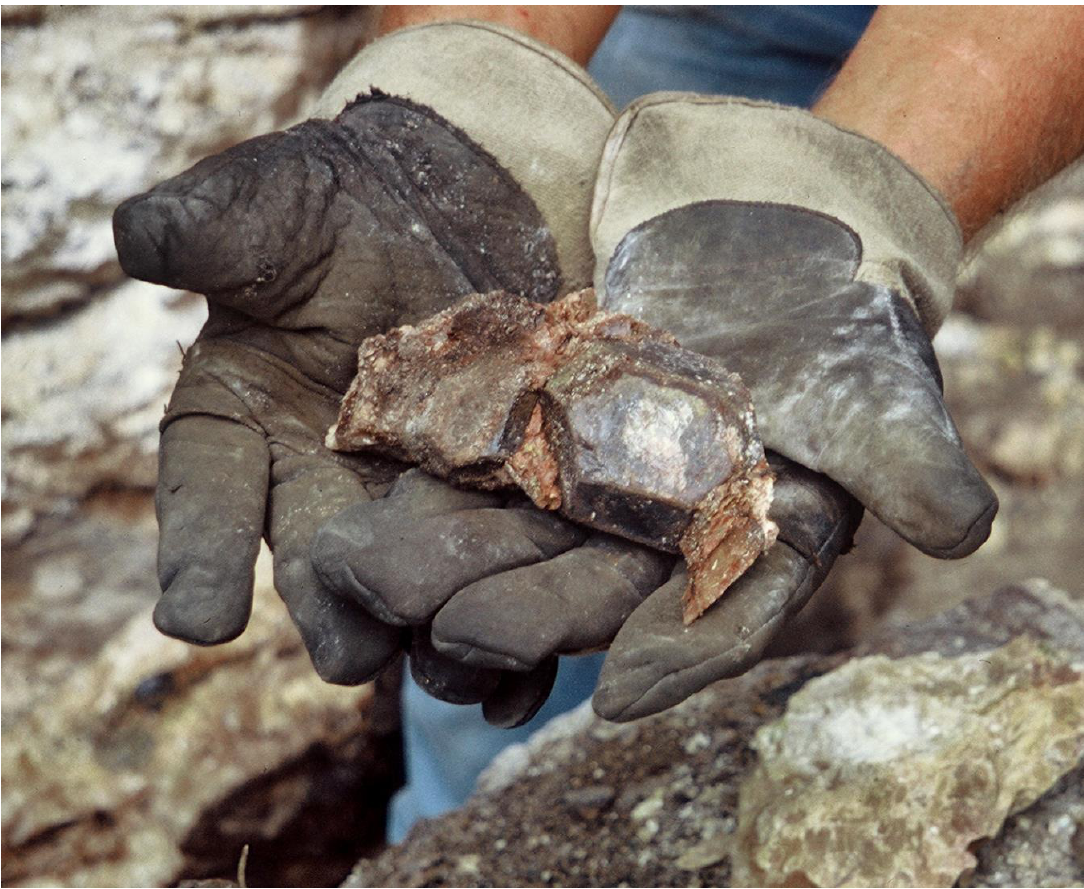
Figure 3. Roughly 9 cm betafite cluster removed from the calcite core of the carbonatite (Figure 1). This specimen shows sharply preserved {100} and {111} faces, common in betafite from the Silver Crater Mine.